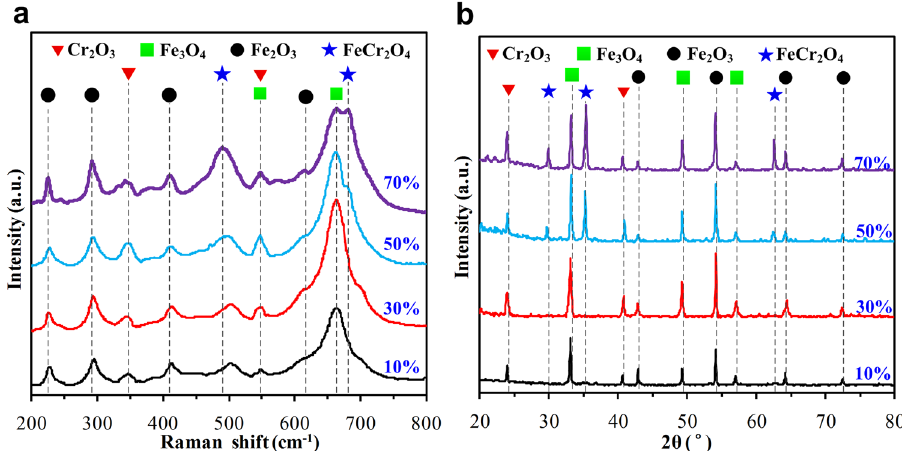
Figure 5. Compositions of the metal oxide films in 10%, 30%, 50% and 70% H 2 O 2 solutions were measured using ( a ) Raman spectroscopy and ( b )